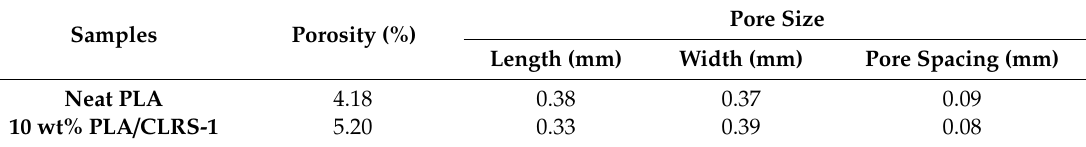
Table 4. The result of porosity analysis via X-ray computed tomography (XCT).